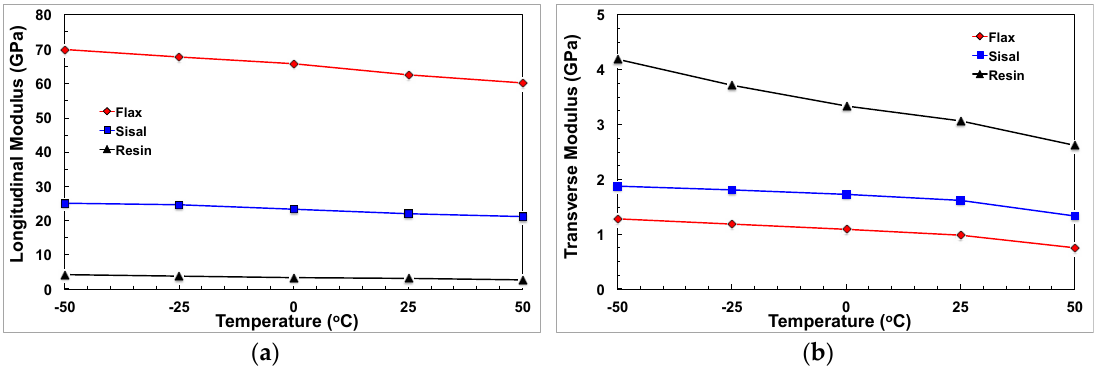
Figure 3. Comparison of the fibre and resin moduli: ( a ) Fibre longitudinal modulus; ( b ) Fibre transverse modulus.